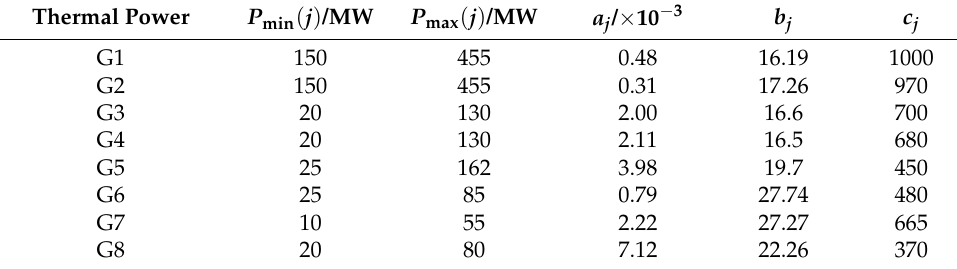
Table 1. Basic parameters of thermal power units.